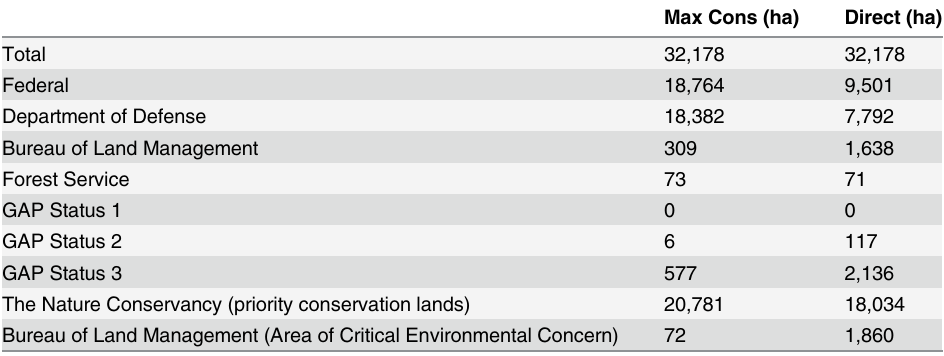
Table 3. Area (ha) in various land status classes for the Max Cons and Direct offset